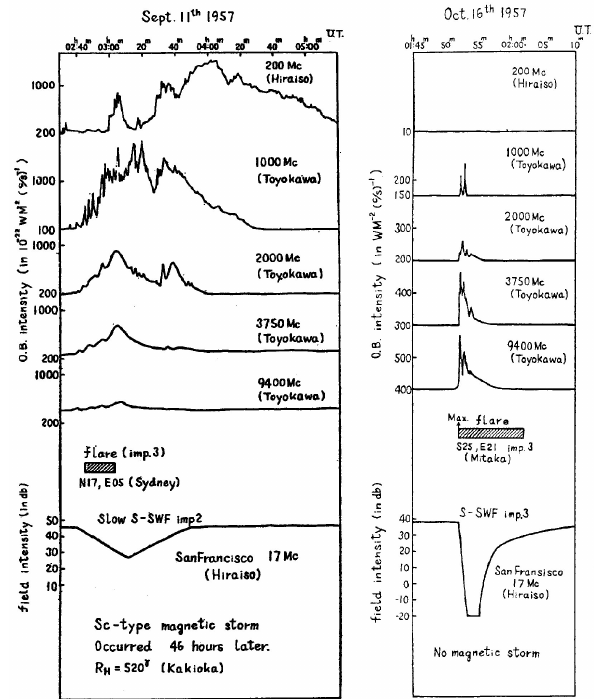
Figure 12. Comparison of spectrum of solar radio bursts (five top curves), interval of flare (shaded box), field intensity of intercon- tinental radio transmission indicating the strength of SWF (bottom curve) and property of magnetic disturbance (handwritten at the bot- tom). Left: a case of low frequency burst and magnetic storm, and right: a case of high frequency burst and no magnetic storm (Sinno and Hakura,